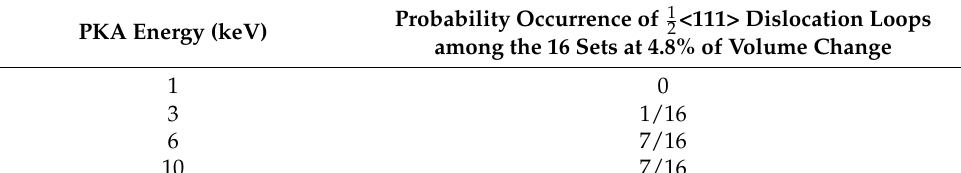
Table 1. Dislocation occurrence probability (i.e., how many times dislocation appeared among the 16 different simulation sets). The only formed dislocation was ½<111> type.